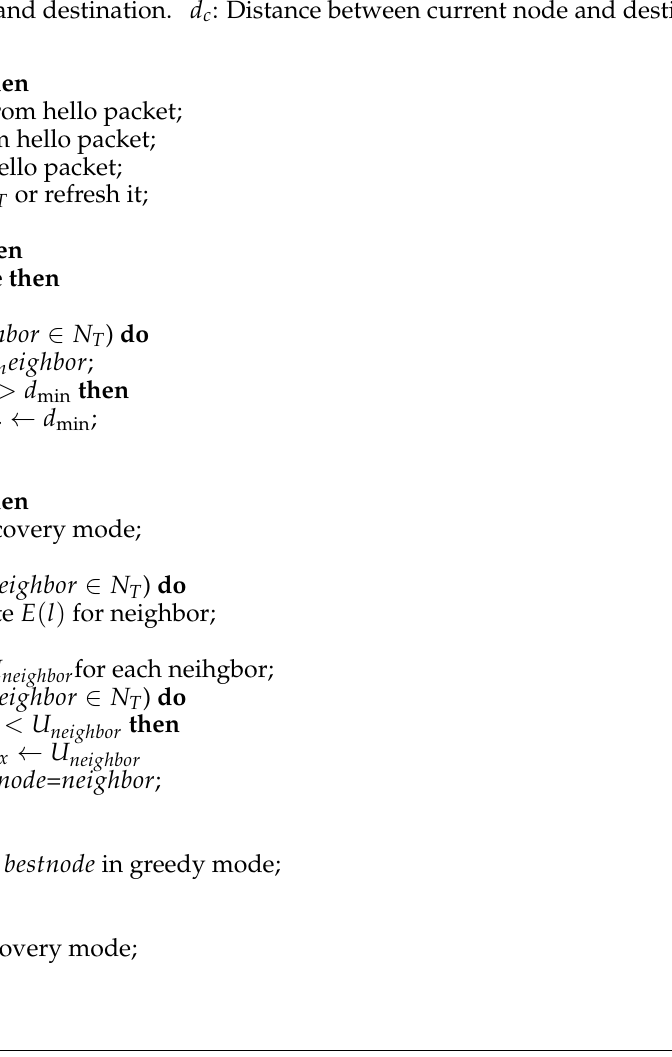
Algorithm 1 Real-time effective information traffic routing (RTEIT)